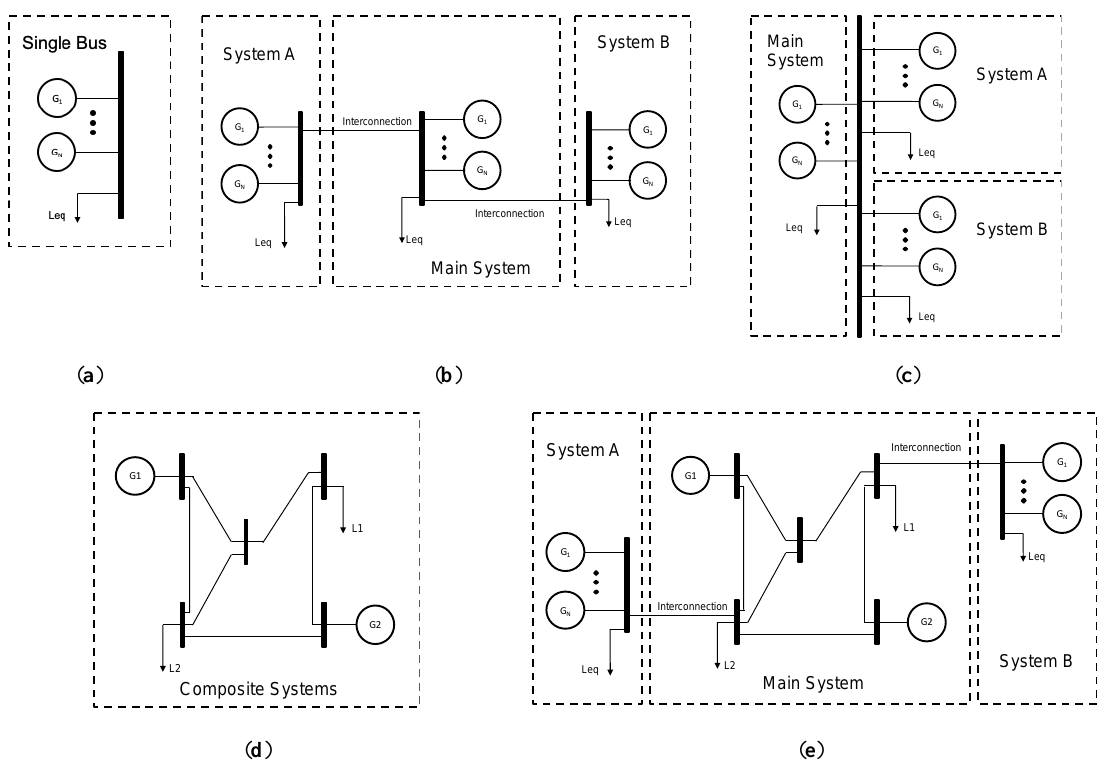
Figure 2. Generation and Transmission Representations. ( a ) Single Bus; ( b ) Single Bus with Interconnections; ( c ) Single Bus Multi-Systems; ( d ) Composite System; ( e ) Composite System in the Main Area and Single Bus in the External